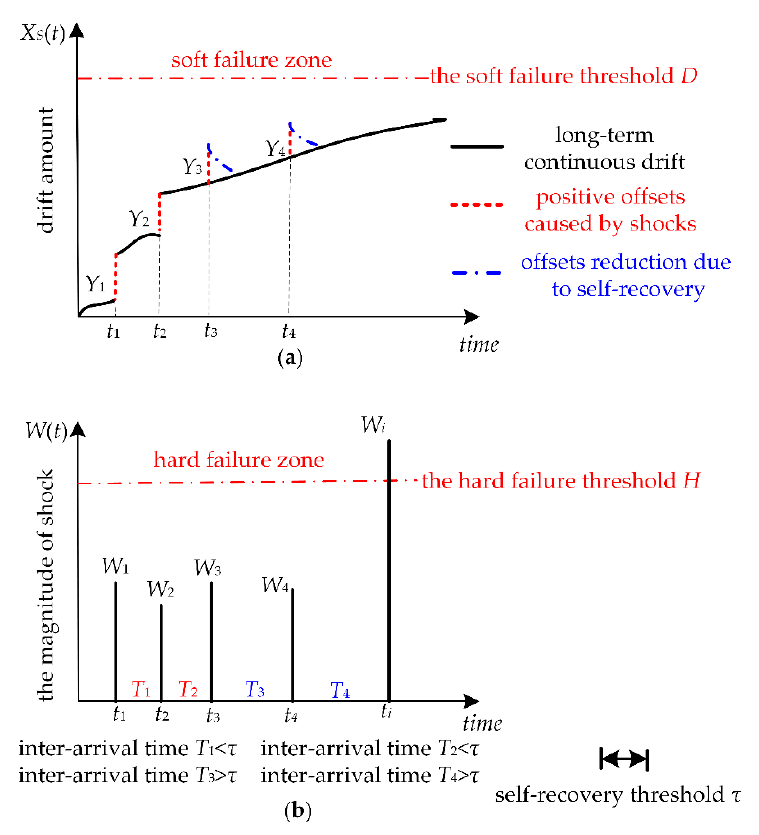
Figure 1. MDCFPs of humidity sensors. ( a ) Soft failure process of humidity sensors; ( b ) Hard failure process of humidity sensors.